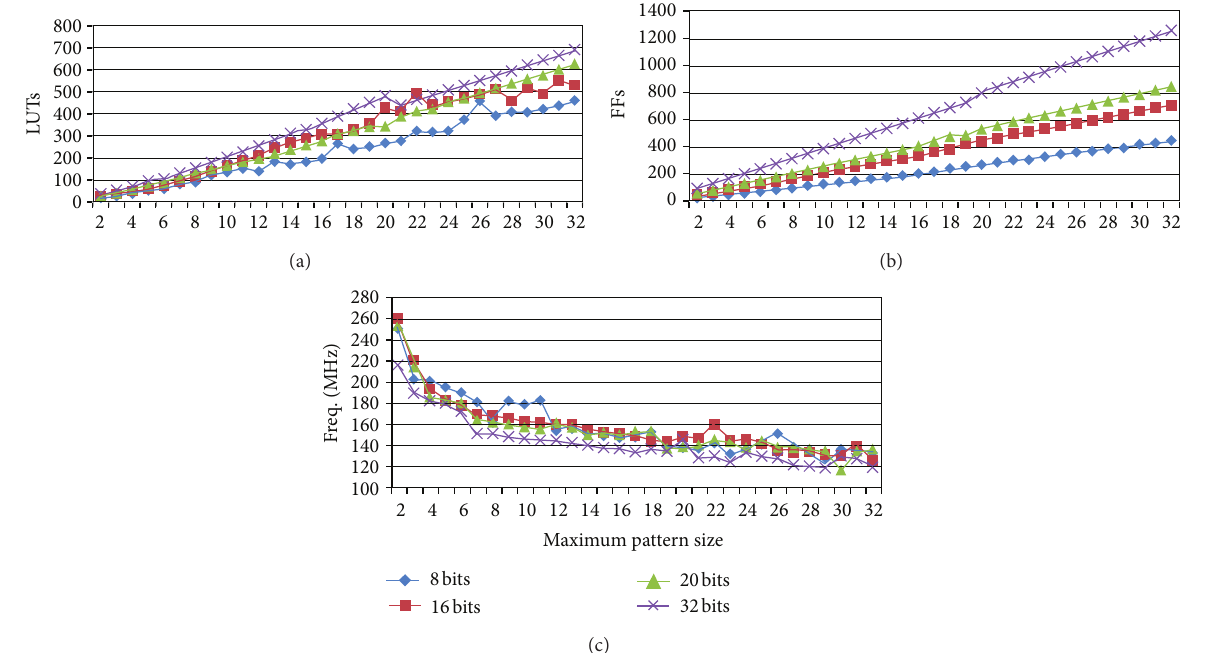
F 17: LUTs, FFs, and estimated maximum frequencies for Megablock Detector hardware designs.